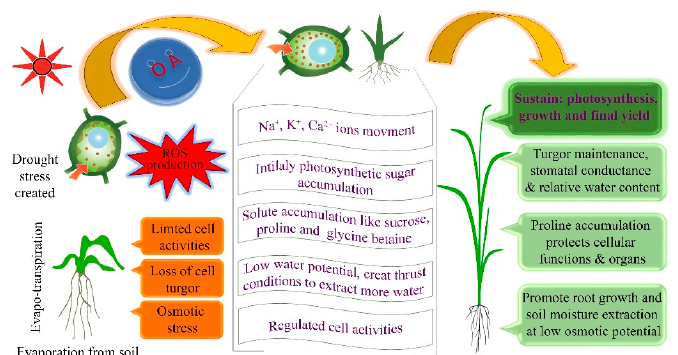
Figure 1. Schematic concept of osmotic adjustment (OA) in plants: how drought coerces to plants for osmotic adjustment under drought stress. Under osmotic stress, plants lose their turgor pressure and water potential, the situation limits the cell activities, and overproduction of reactive oxygen species (ROS) which stimulate the accumulation of water-soluble components for OA. Osmotic adjustment promotes root growth and water extraction from the soil. It maintains the stomatal conductance and turgor pressure to restore the cell activities, photosynthesis, and finally improved plant growth and yield.